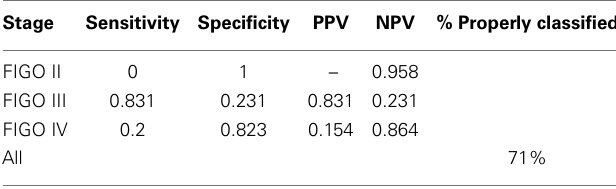
Table 4 | Classification of tumor samples according to FIGO stage (linear discriminant